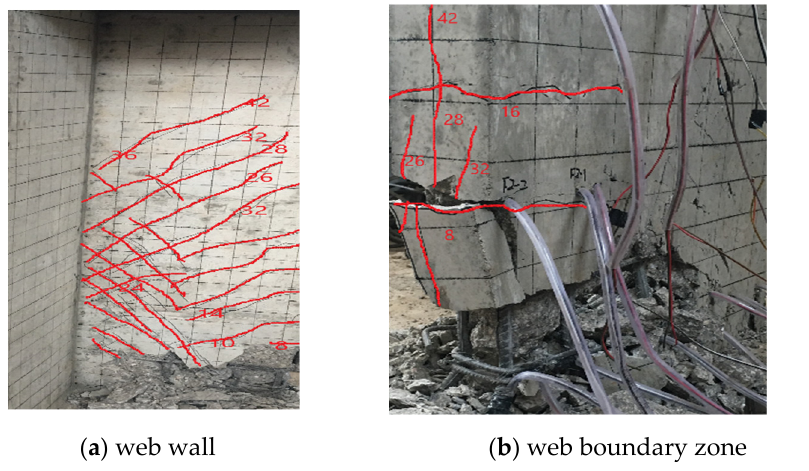
Figure 8. Crack patterns of HPLW500-1 at failure stage.